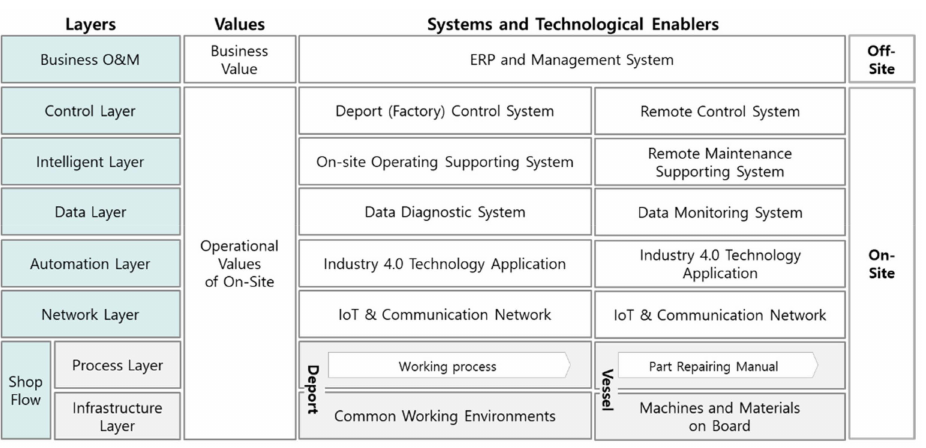
Figure 6. Architecture of a smart maintenance